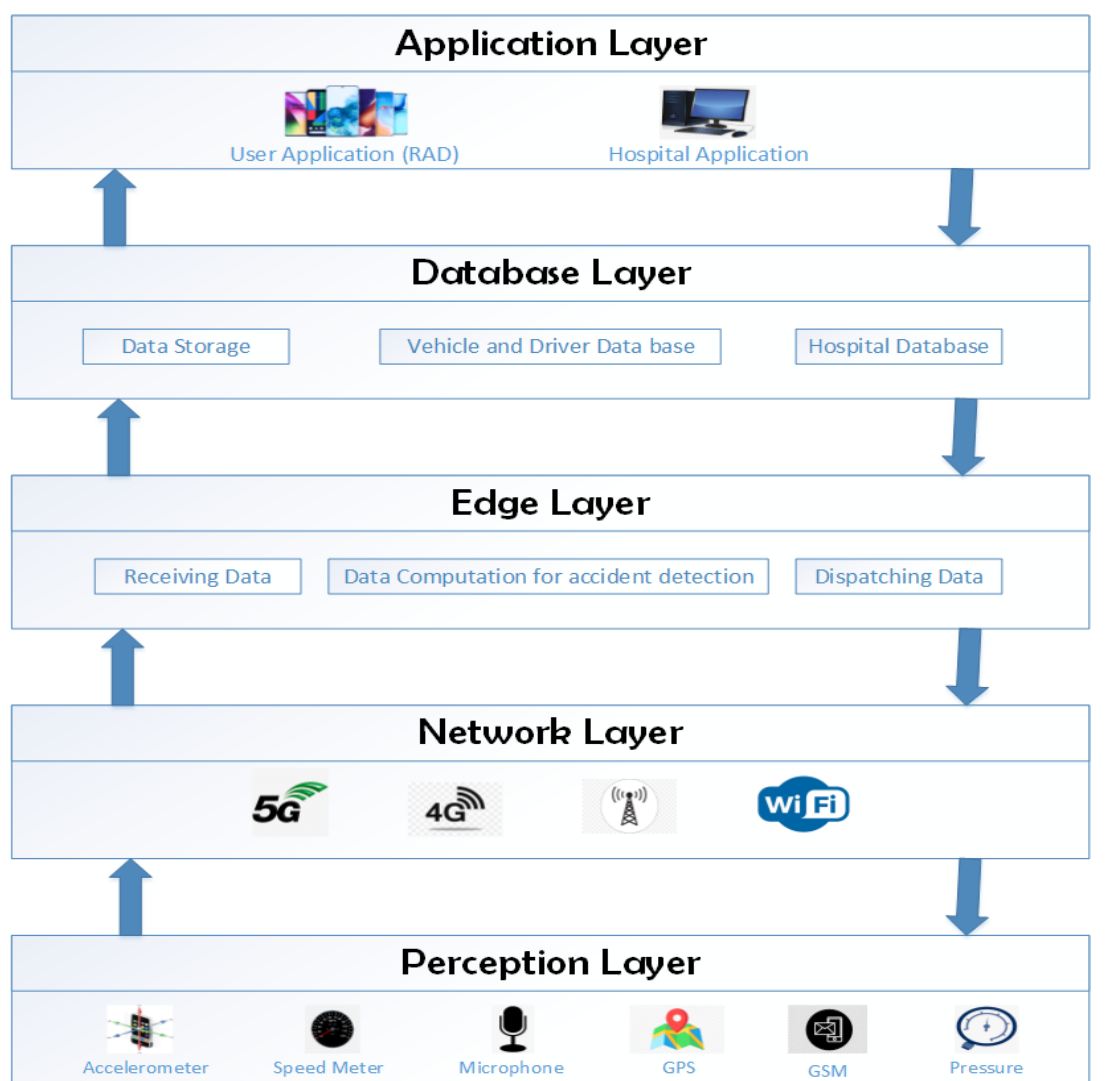
Figure 1. Reporting and Accident Detection (RAD)